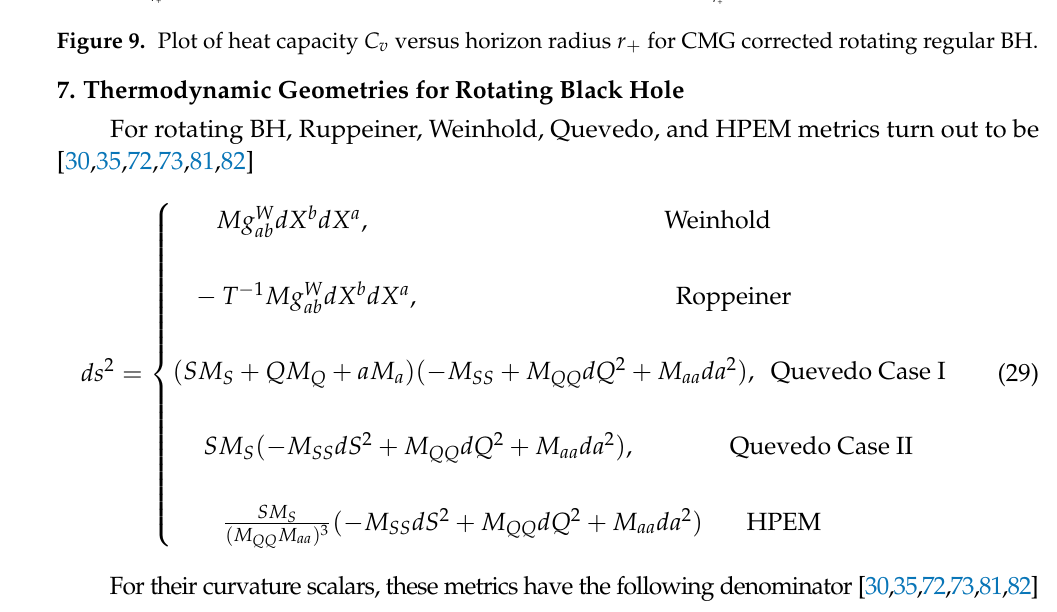
Figure 9. Plot of heat capacity C v versus horizon radius r + for CMG corrected rotating regular